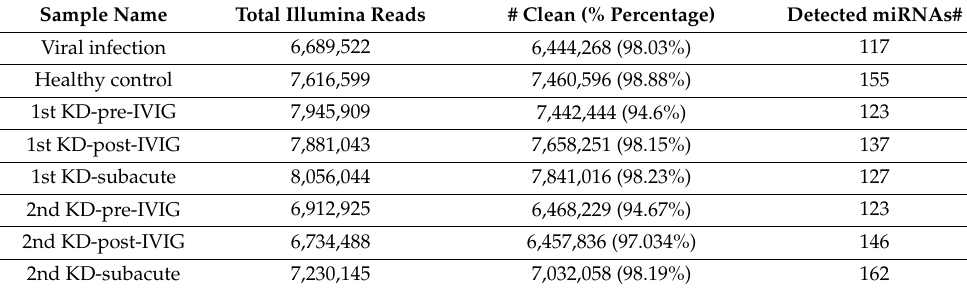
Table 1. Categories of sequence reads in the eight